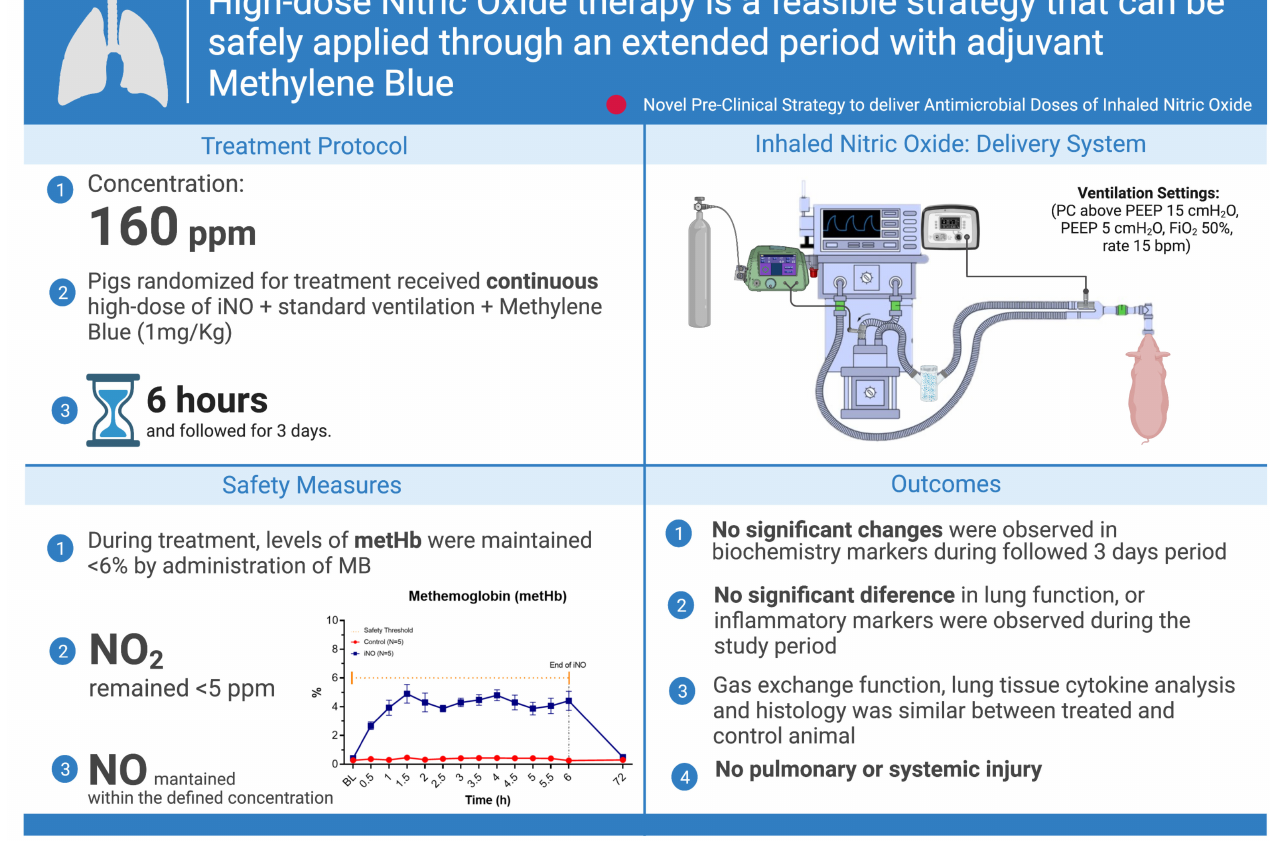
Figure 6. Visual summary of the feasible strategy to safely deliver in vivo high doses of nitric oxide with adjuvant methylene blue. Definition of abbreviations: ppm = parts per million, NO = nitric oxide, iNO = inhaled nitric oxide, metHb = methemoglobin, NO 2 = nitrogen dioxide, MB = methylene blue, PC = pressure control, PEEP = positive end-expiratory pressure, bpm = beats per minute, FiO 2 = fraction of inspired oxygen. The figure was created with BioRender.com (accessed on 22 June